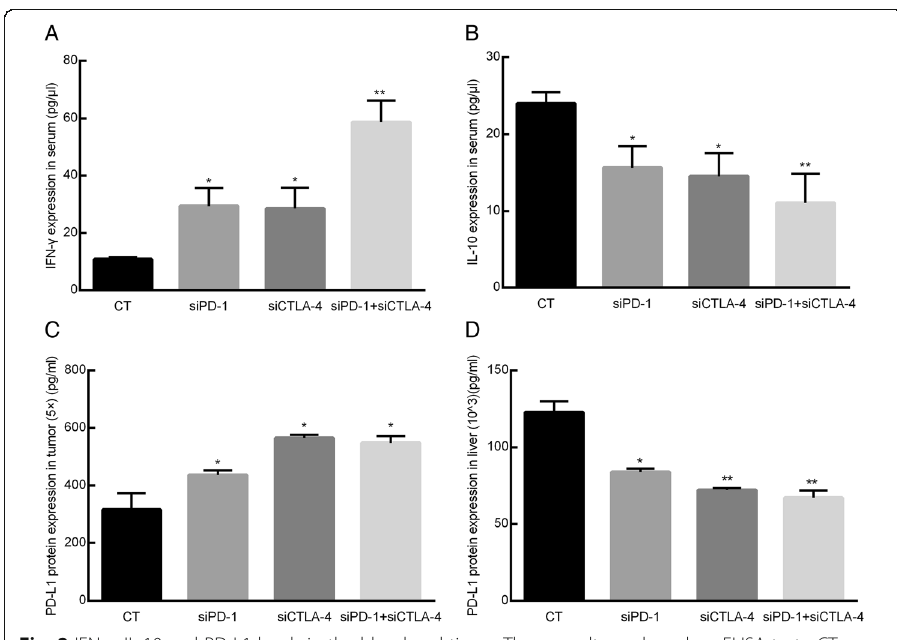
Fig. 2 IFN- γ , IL-10 and PD-L1 levels in the blood and tissue. These results are based on ELISA tests. CT = control, siPD-1 = group injected with siRNA for PD-1, siCTLA-4= group injected with siRNA for CTLA-4, siPD-1 + siCTLA-4 = group injected with siRNA for PD-1 + CTLA-4. a – IFN- γ level in mouse serum. b – IL-10 level in mouse serum. c – PD-L1 level in tumor tissue. d – PD-L1 content in liver tissue. The expressions